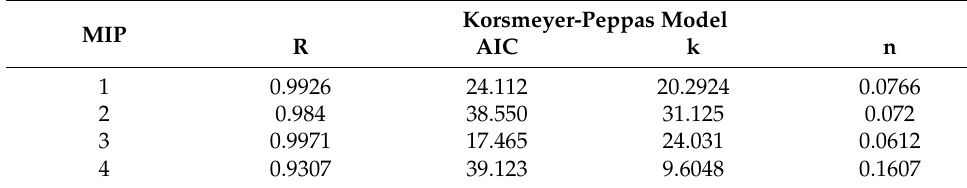
Table 4. Drug release kinetics at pH = 7.4.